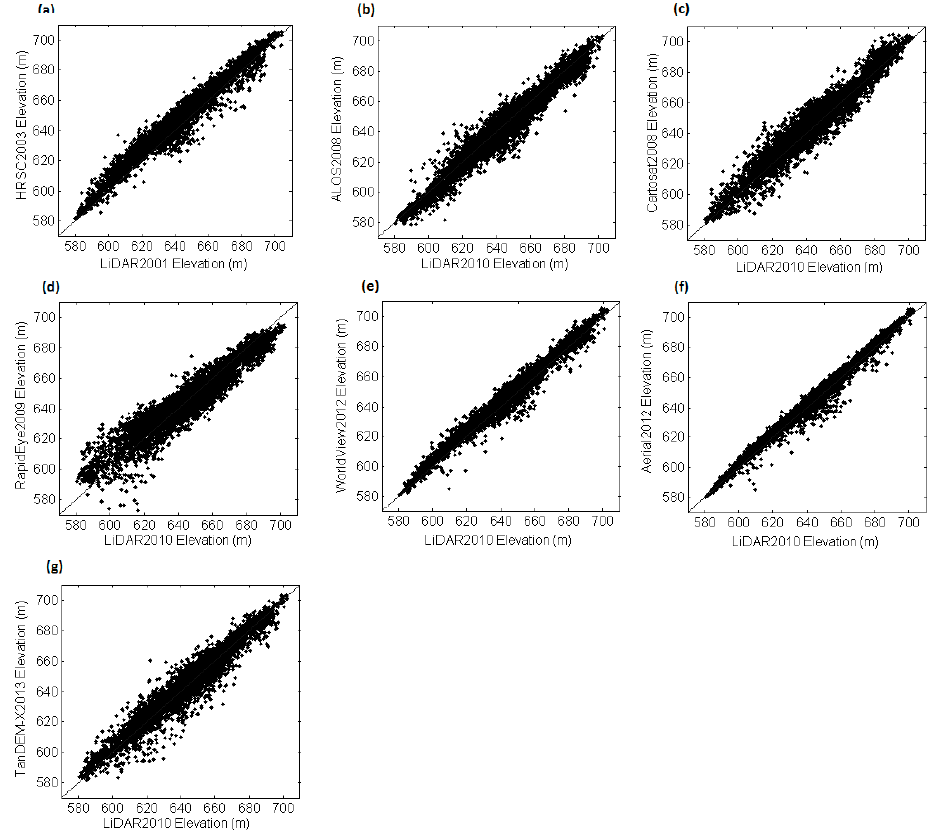
Figure 5. Comparison of mean DSM height values for 500 m 2 grid cells from HRSC2003 ( a ) ALOS2008 ( b ), Cartosat2008 ( c ), RapidEye2009 ( d ), WorldView2012 ( e ), Aerial2012 ( f ) and TanDEM-X2013 ( g ) with the corresponding heights as derived from the LiDAR2001 and LiDAR2010 DSM ( n = 6931).